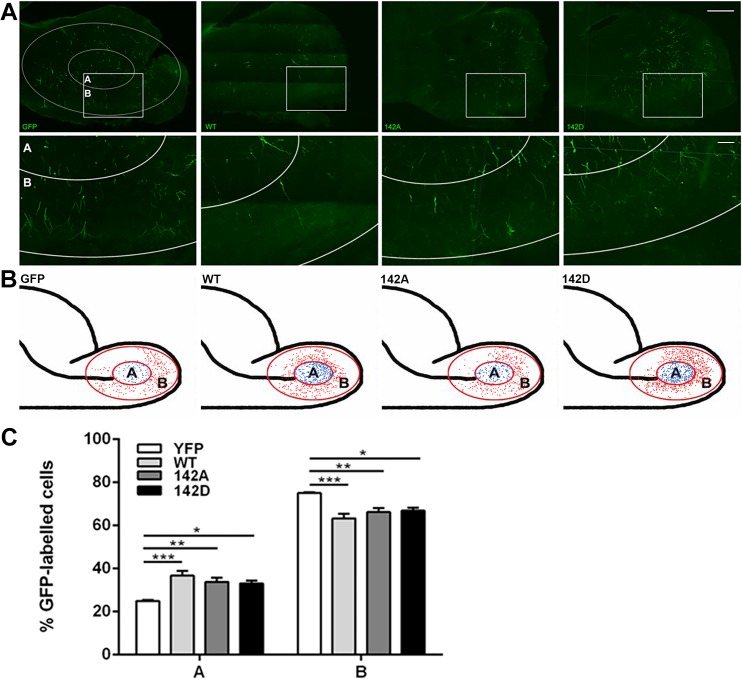
Altering levels of drebrin and pS142 phosphorylation of drebrin affects neuroblast distribution in the OB.P2 mice were electroporated in the lateral ventricle with plasmids encoding YFP or YFP-tagged wt, S142A or S142D drebrin. Sagittal brain slices were prepared 14 days later and immunostained for YFP. (A, top row) Representative confocal projections of sagittal brain slices showing overall labeling in the OB and overlaid with the mask used for analysis (area A, inner OB; area B, outer OB). High magnification pictures of the OB insets are shown in the bottom row. (B) Schematic diagrams of a typical quantification analysis using all OB sections from one brain for each condition. Cell bodies in areas A and B are represented as dots. (C) Overexpression of wt, S142A and S142D drebrin caused a significant cell accumulation in the inner OB compared to GFP (mean ± SEM; n = 3 brains for each construct; *P<0.05, **P<0.01, ***P<0.001). Scale bars: (A, top row), 500 μm; (A, bottom row), 100 μm.